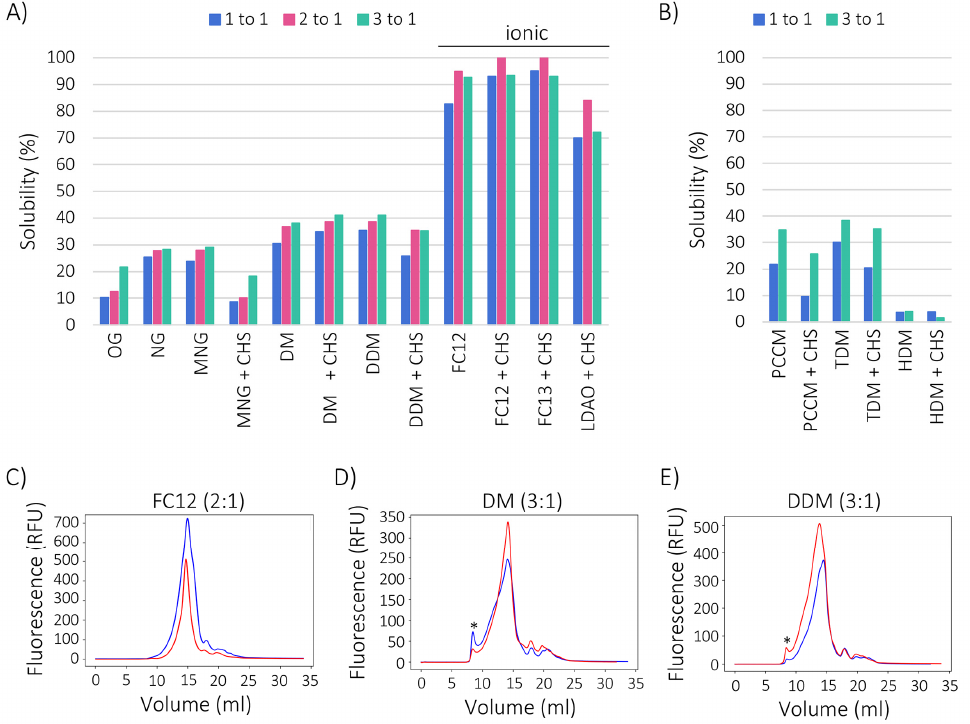
Figure 4. GFP-FICD maintains a folded conformation upon solubilisation. ( A ) Percentage solubility of GFP-FICD in the indicated detergent conditions (see Table 1 for detergent names and properties). When noted, solubilisation was performed in the presence of CHS. Fluorescence intensity was measured in the soluble fraction after ultracentrifugation, and solubility was quantified as the proportion of fluorescence in the soluble fraction relative to total membrane fluorescence. Solubility in three different detergent to protein ratios (1:1, 2:1 and 3:1) is shown. ( B ) GFP-FICD solubility measured as in A, but in two detergent to protein ratios (1:1 and 3:1). ( C – E ) FSEC profiles of GFP-FICD solubilised in the indicated detergents in the highest yielding detergent to protein ratio (FC12; 2:1 ( C ), DM; 3:1 ( D ), DDM; 3:1 ( E )). An in-line fluorescence detector was used to record the elution profile of GFP-FICD. Blue line, without CHS; red line, with CHS. Fluorescent material eluting in the void volume is denoted by an asterisk (*).